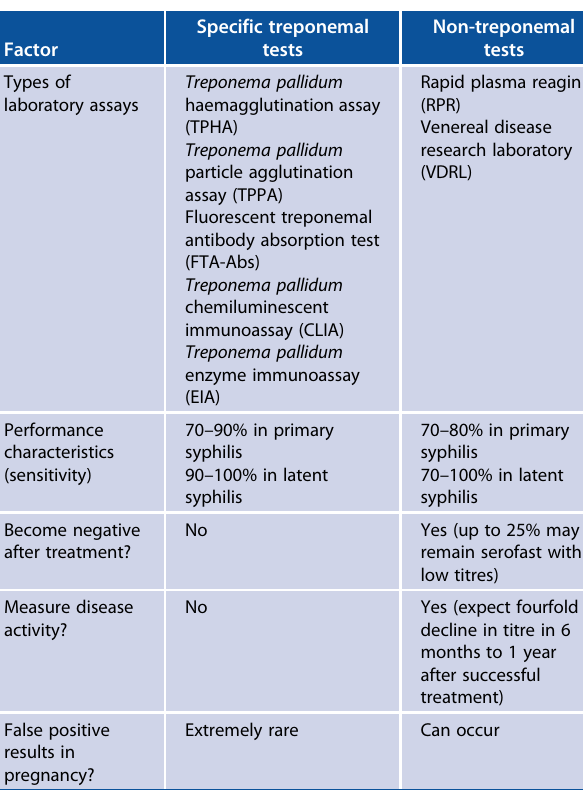
False positive results